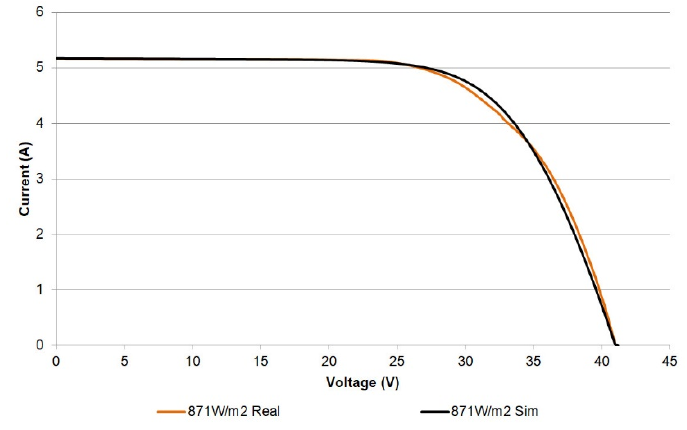
Figure 16. Experimental and simulated I ‐ V curves for a single PV module at 871 W/m 2 .